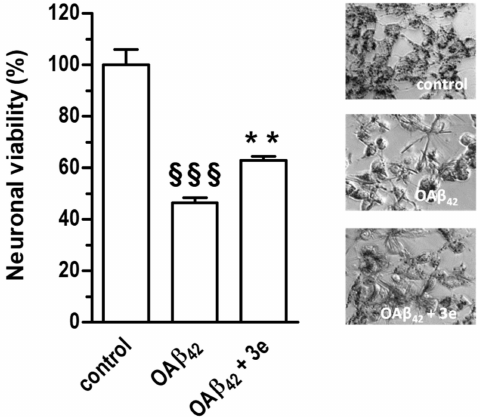
Figure 7. Compound 3e counteracts the neurotoxicity induced by OA β 42 in SH-SY5Y cells. Cells were treated for 4 h with 3e (5 µ M) and O β A 42 (10 µ M). At the end of incubation, the neuronal viability